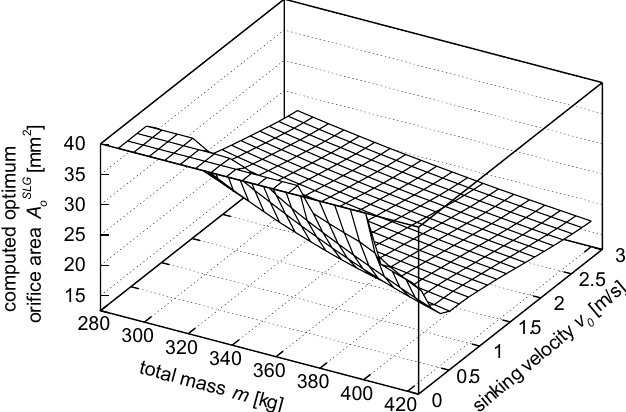
Fig. 7. Semi-active LG: Computed dependence of the optimum discharge orifice area on the total mass m and sinking velocity v 0 .